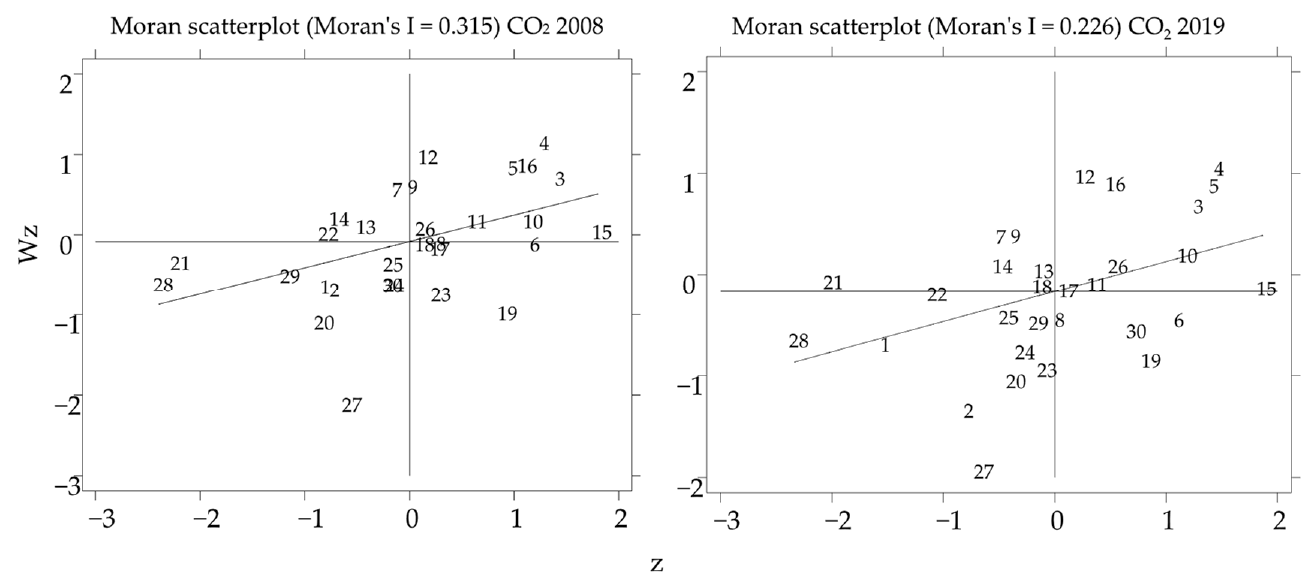
Figure 3. Moran’s I scatter plot of carbon emission.